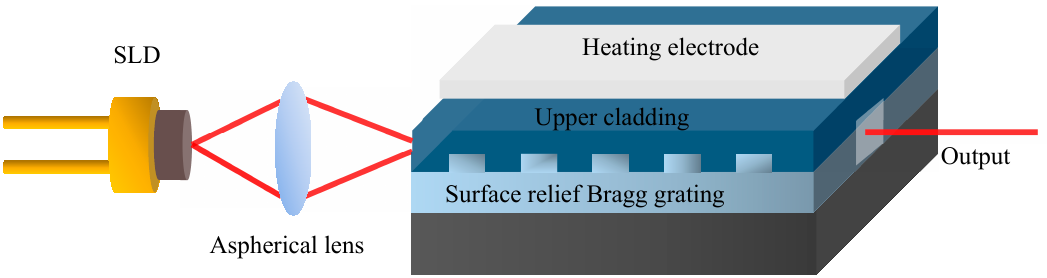
Figure 1. Schematic of a wavelength-swept thermo-optic laser